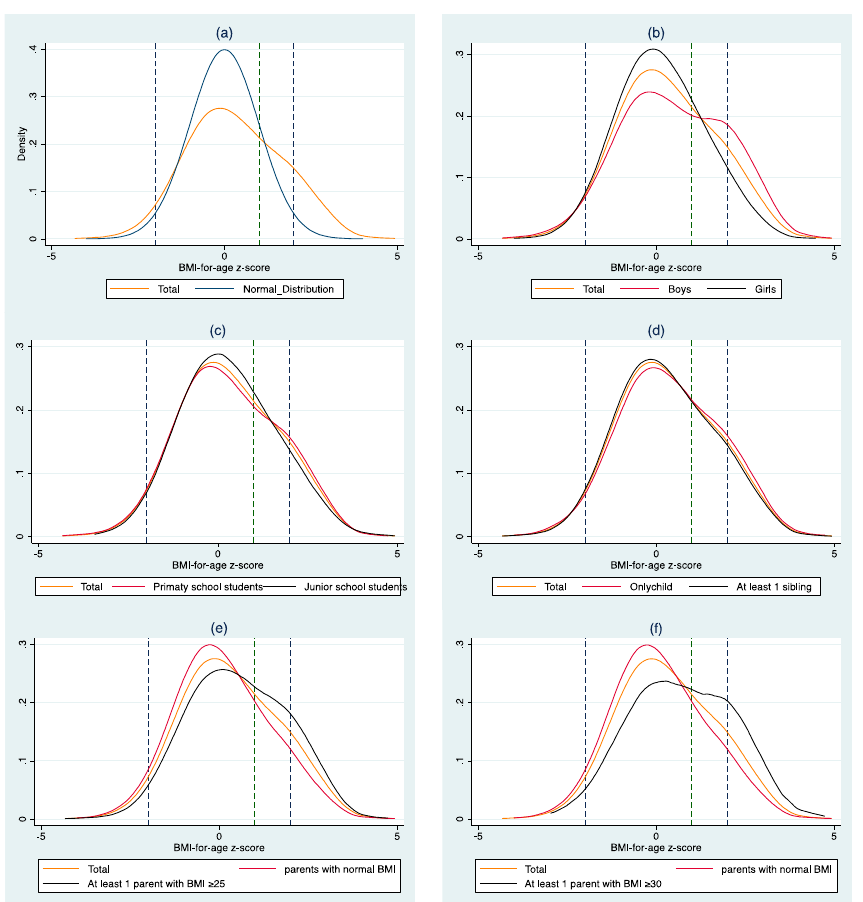
Figure 2. Distribution of body mass index-for-age z-score for entire sample, subgroups, and normal distribution (Mean = 0, Standard deviation = 1). ( a ): Distribution of BMI-for-age z-score for the entire sample and normal distribution; ( b ): Distribution of BMI-for-age z-score for the entire sample and subgroups (grouped by gender); ( c ): Distribution of BMI-for-age z-score for the entire sample and subgroups (grouped by school type); ( d ): Distribution of BMI-for-age z-score for the entire sample and subgroups (grouped by sibling number); ( e , f ): Distribution of BMI-for-age z-score for the entire sample and subgroups (grouped by parental health status).